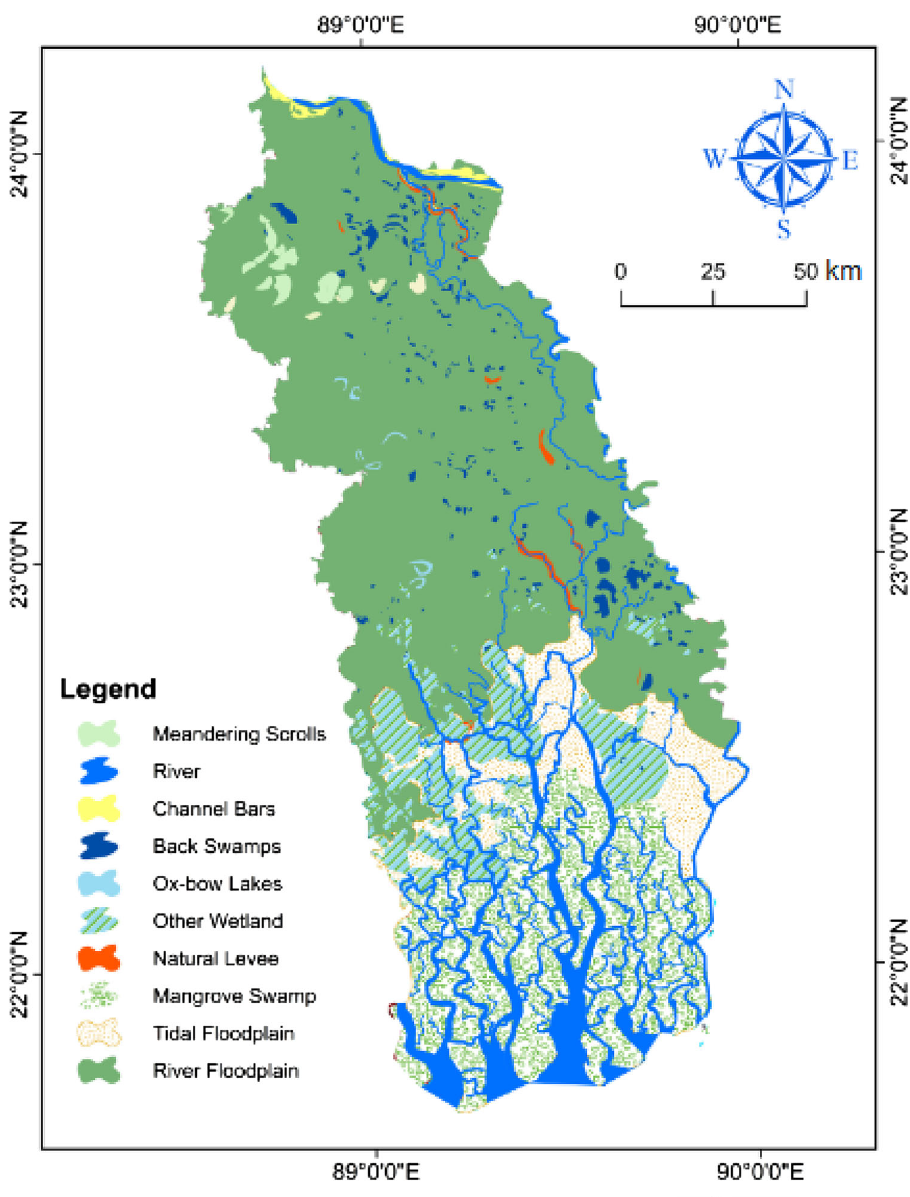
Fig. 2 Geomorphological map of the